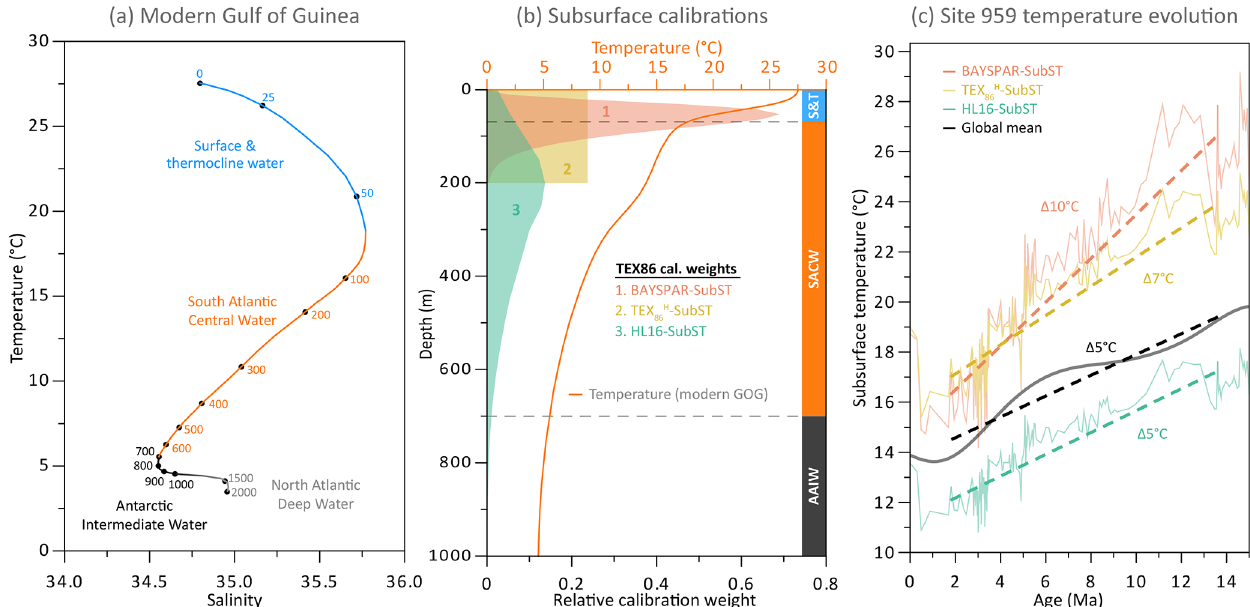
Figure 8. (a) Temperature and salinity distribution along a depth transect in the modern Gulf of Guinea (numbers: meters below sea surface), data from Locarnini et al. (2013) and Zweng et al. (2013). (b) Vertical weight distribution of the discussed SubST calibrations (silhouettes) and the water column composition in the modern Gulf of Guinea. (c) Site 959 TEX H -SubST evolution according to different SubST cali- 86 brations, compared to global mean temperature evolution (Tierney et al., 2020). (cid:49) Temperature estimated from linear trends (dashed lines) between the Middle Miocene and